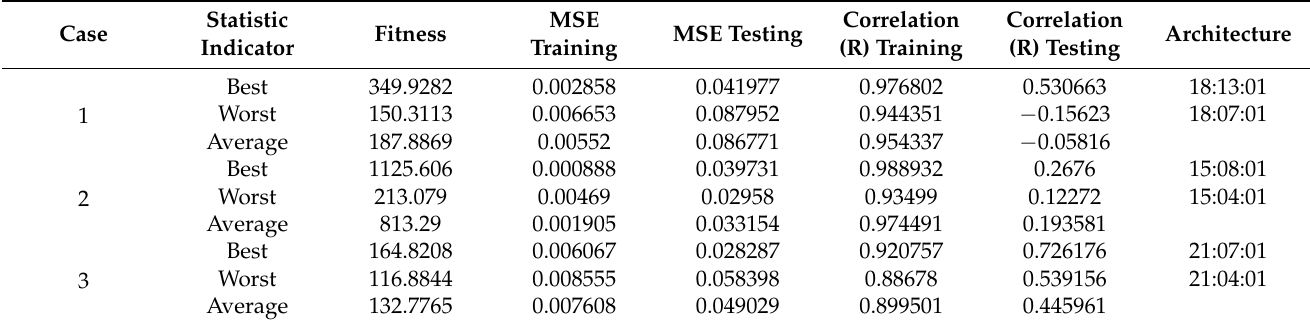
Table 1. Statistics for the models